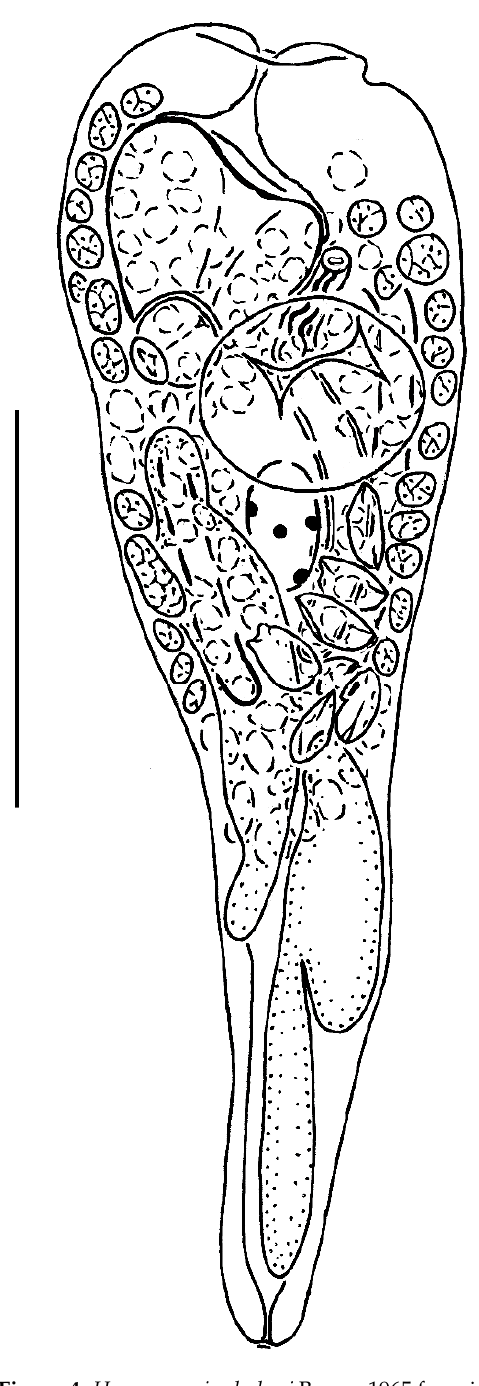
Figure 4. Hexagrammia zhukovi Baeva, 1965 from intestine of Rock greenling Hexagrammos lagocephalus (Pallas, 1810) (Hexagrammidae), the Sea of Okhotsk. Trematode specimen with invaginated oral sucker. Scale bar = 400 µm.